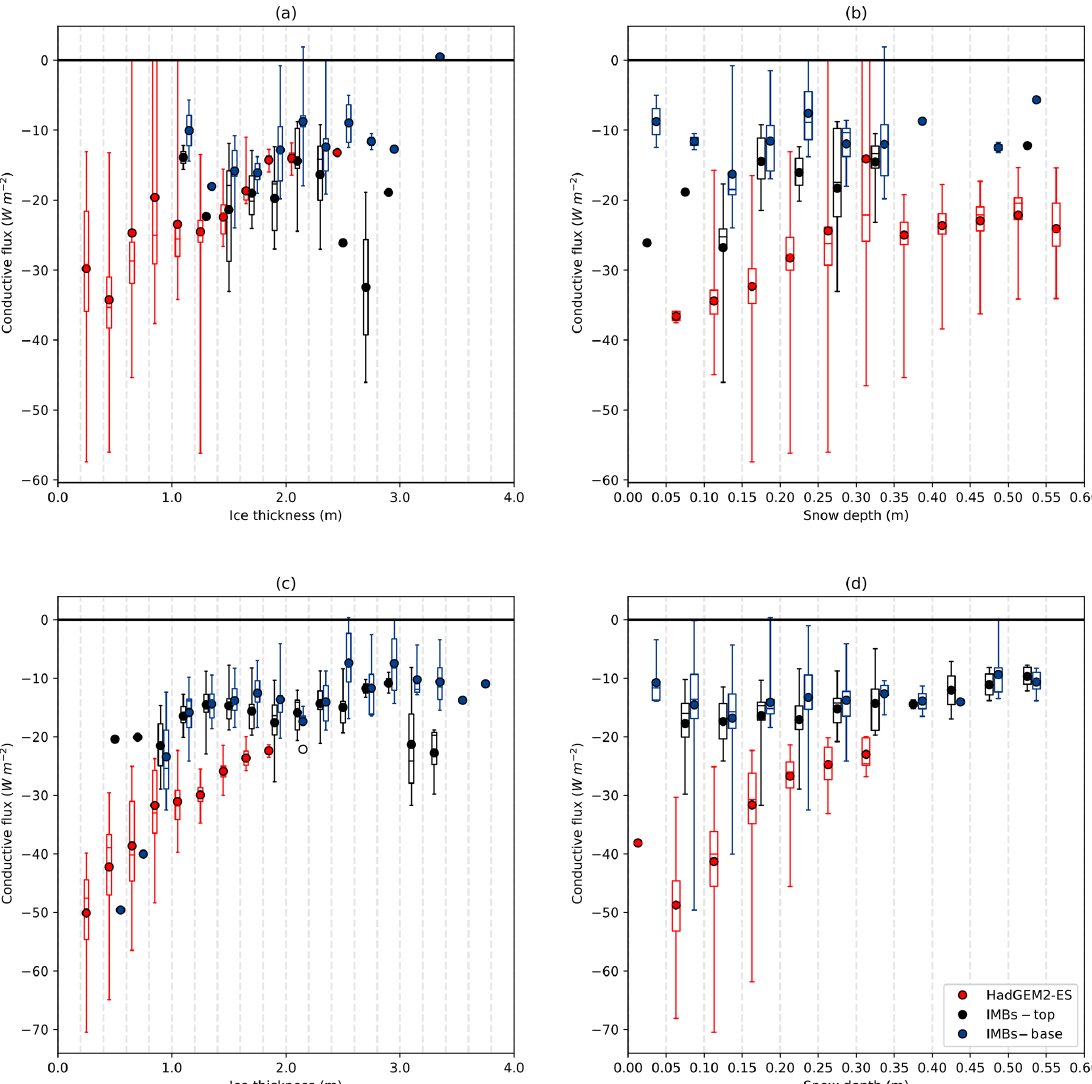
Figure 10. Conductive fluxes plotted according to (a, c) ice thickness and (b, d) snow depth for the (a, b) North Pole and (c, d) Beaufort Sea